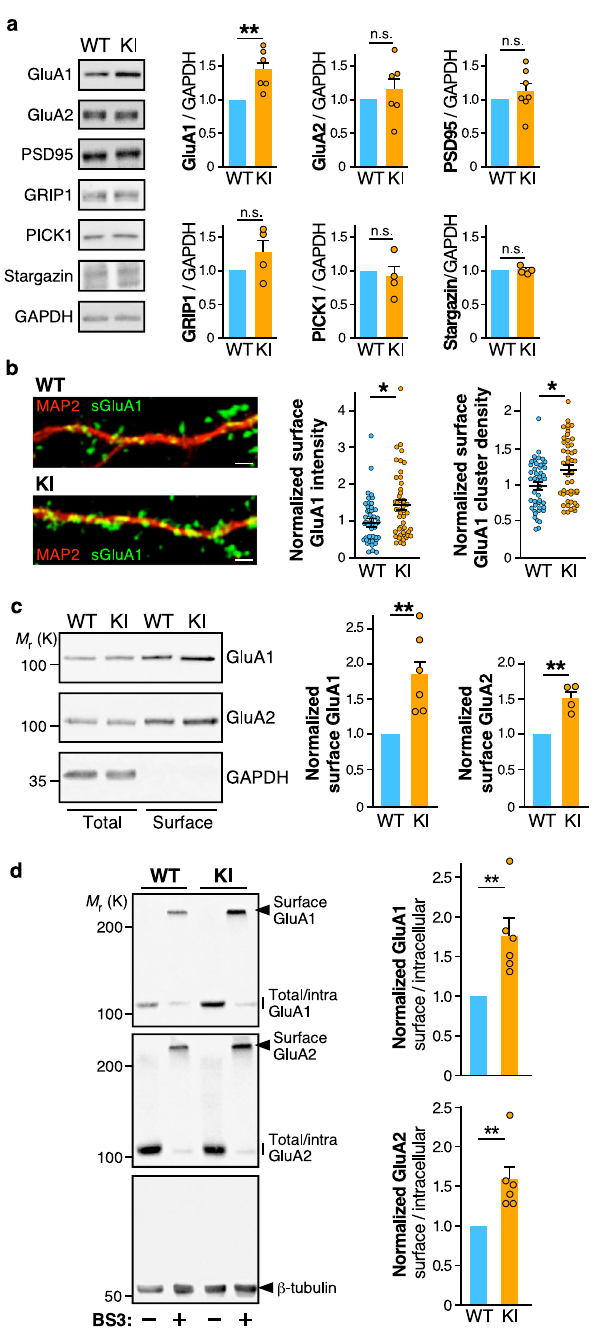
number of both surface-associated GluA1 and GluA2 nanodo- mains (Fig. 4d, Fmr1 R138Q sGluA1: 2.582 ± 0.106; Fmr1 R138Q sGluA2 2.554 ± 0.078). These data indicate that the missense R138Q mutation leads to a signi fi cant increase in the number of postsynaptic nanodomains containing AMPARs. However, while the mean fl uorescence associated with surface-expressed GluA1 is also increased in hippocampal Fmr1 R138Q synapses, the synaptic fl uorescence level from surface-labeled GluA2 is decreased revealing that the upregulation of surface GluA2 measured in biochemical experiments is rather due to its extrasynaptic increase. This indicates that the FXS mutation not only impacts the surface expression of both GluA1 and GluA2 but also dif- ferentially perturbs their synaptic targeting, traf fi cking, and nanoscale organization.